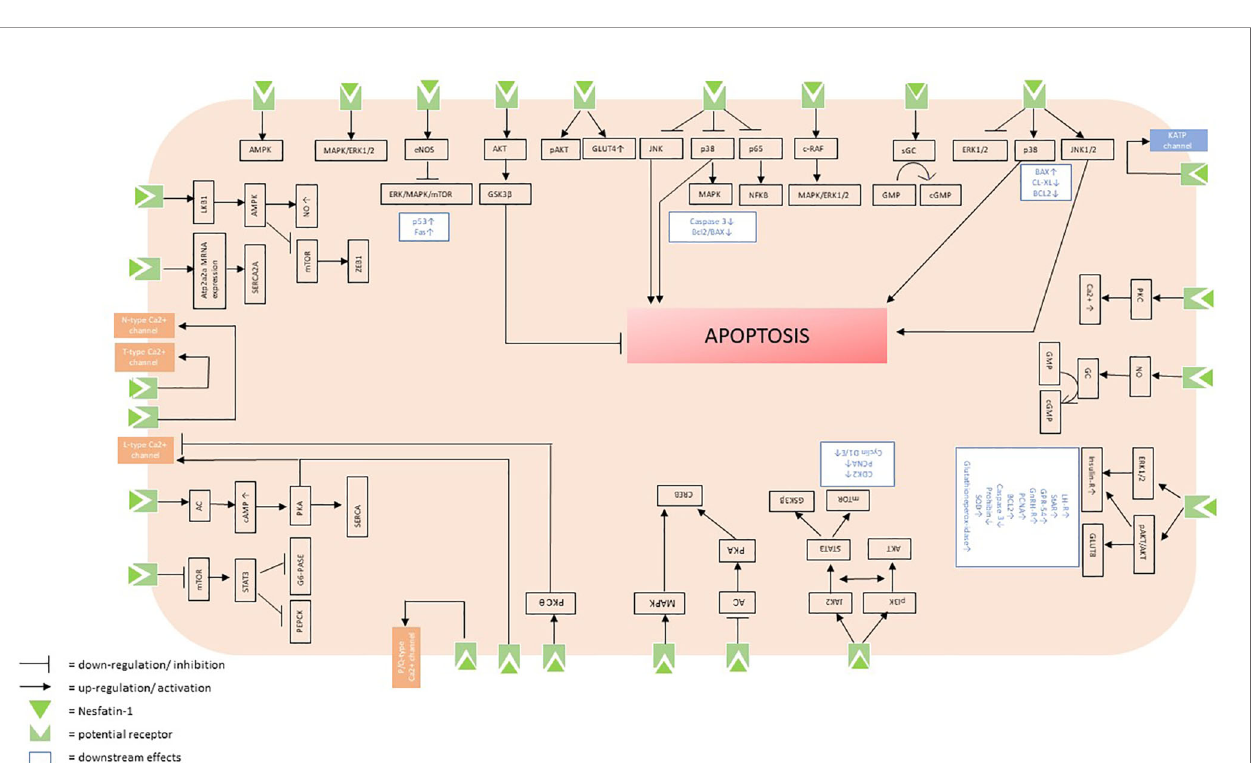
FIGURE 2 | Putative intracellular signaling cascades initiated by the binding of nesfatin-1 to its